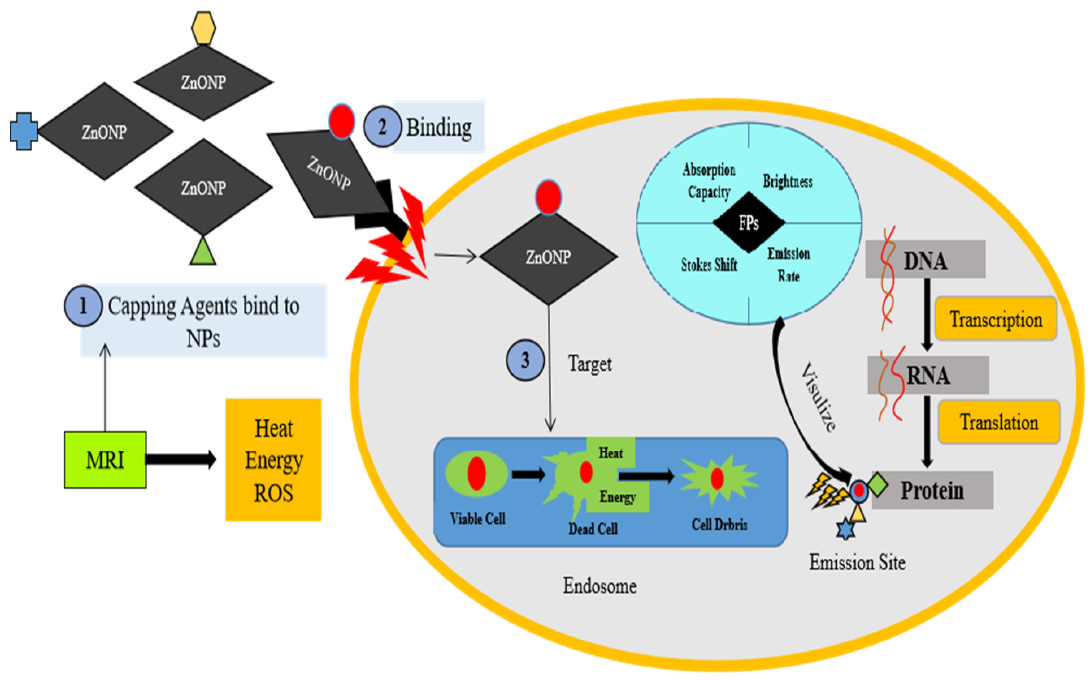
Figure 6. Demonstrated that entrance of ZnO NPs in animal cells required heat energy. Fluorescent probes associated with ZnO NPs act as capping agents damaging the plasma membrane of cells. Endosomes are responsible for excretion of cell debris. Fluorescent probes appeared on target tissue or attached on the surface of proteins.